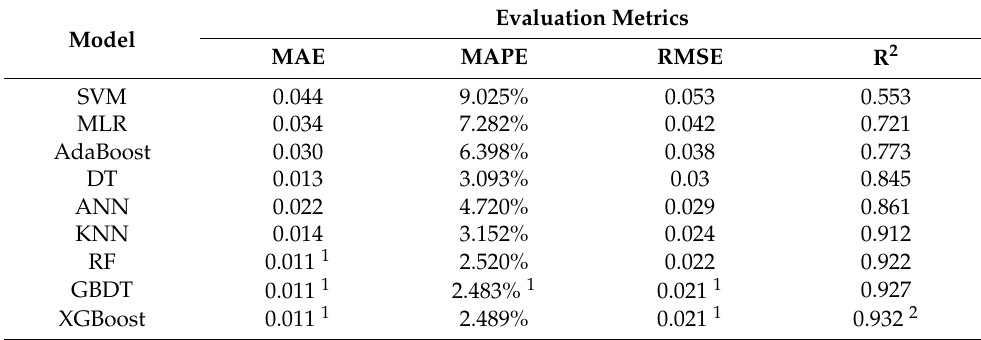
Table 2. The model’s performance on the simulated wild blueberry pollination